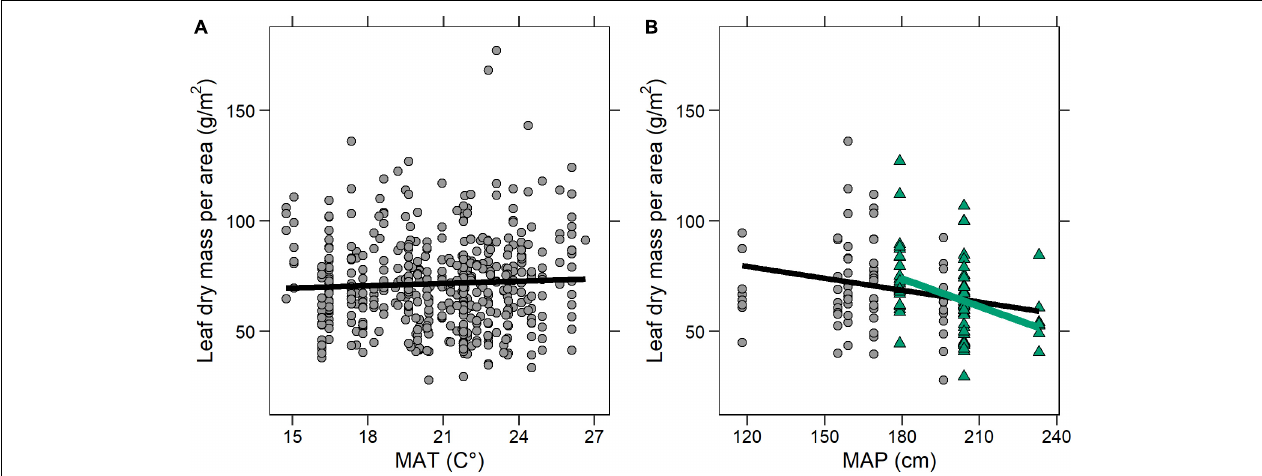
FIGURE 7 | Correlations between LMA and climate. Each point is a species-site pair. (A) LMA and mean annual temperature (MAT). LMA = 63.25 + 0.40 × MAT (Adjusted R 2 = 0.001; p = 0.20). (B) LMA and mean annual precipitation (MAP). Black line is the whole basin regression: LMA = 100.84 – 0.18 × MAP (Adjusted R 2 = 0.05; p = 0.004). Green triangles are P-D-West species-site pairs, and the green line is the P-D1-West regression: LMA = 148.81–0.42 × MAP (Adjusted R 2 = 0.14; p <